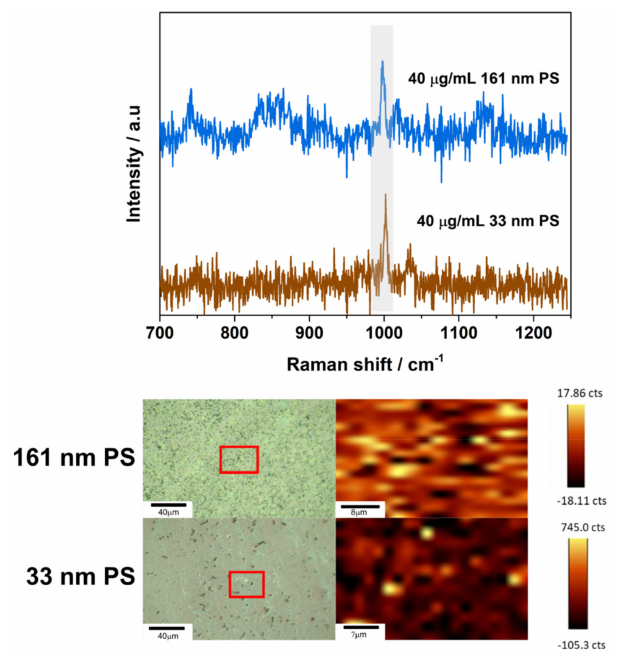
Figure A8. Additional representative SERS spectra obtained through automated mapping for 40 µ g/mL samples of 161 nm PS particles on 46 nm AuNP substrates and 40 µ g/mL samples of 33 nm PS nanopar- ticles on 46 nm AuNP substrates. Laser power, scan speeds, and number of averaged accumulations for the samples can be viewed in Table A1. Spectrum obtained are shown above images of the intensity maps for the PS peak at 1002 cm − 1 and the regions of interest (ROIs) the measurement was obtained from. Spectra come from regions of high intensity for the peak at 1002 cm − 1